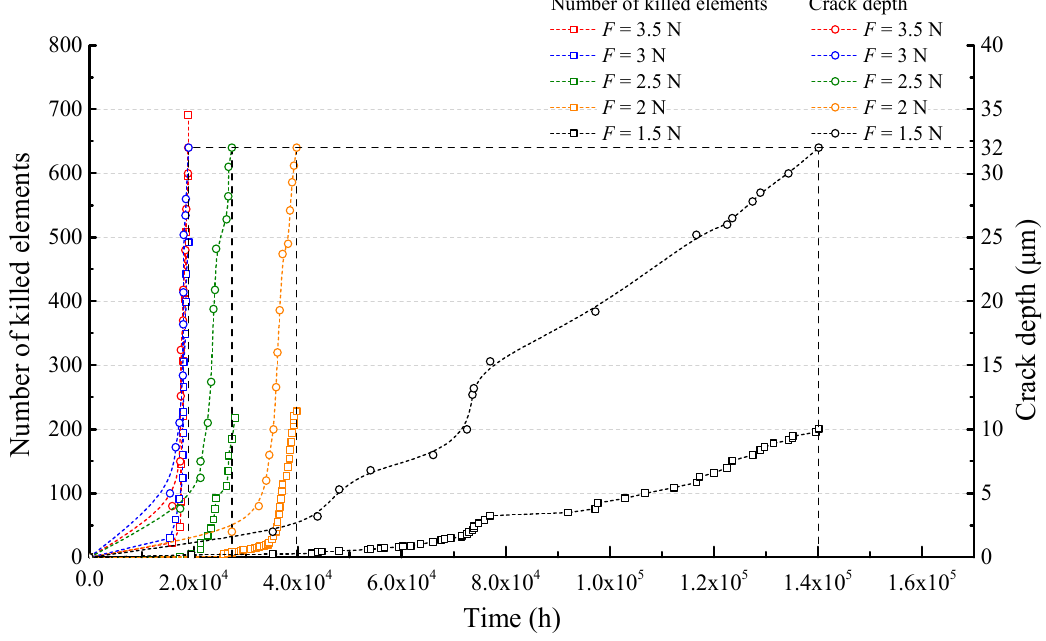
Figure 10. Crack depth and number of elements killed vs time in the case of different loads F .